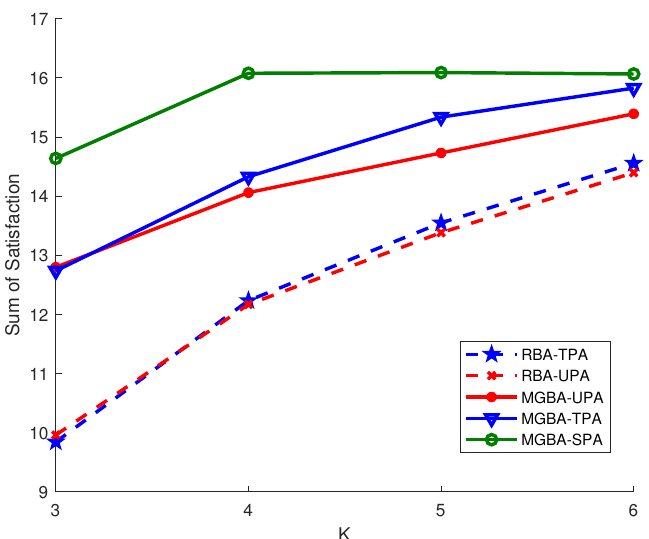
Figure 3. The sum of satisfaction performance comparison against different numbers of cooperative LEO satellites K .